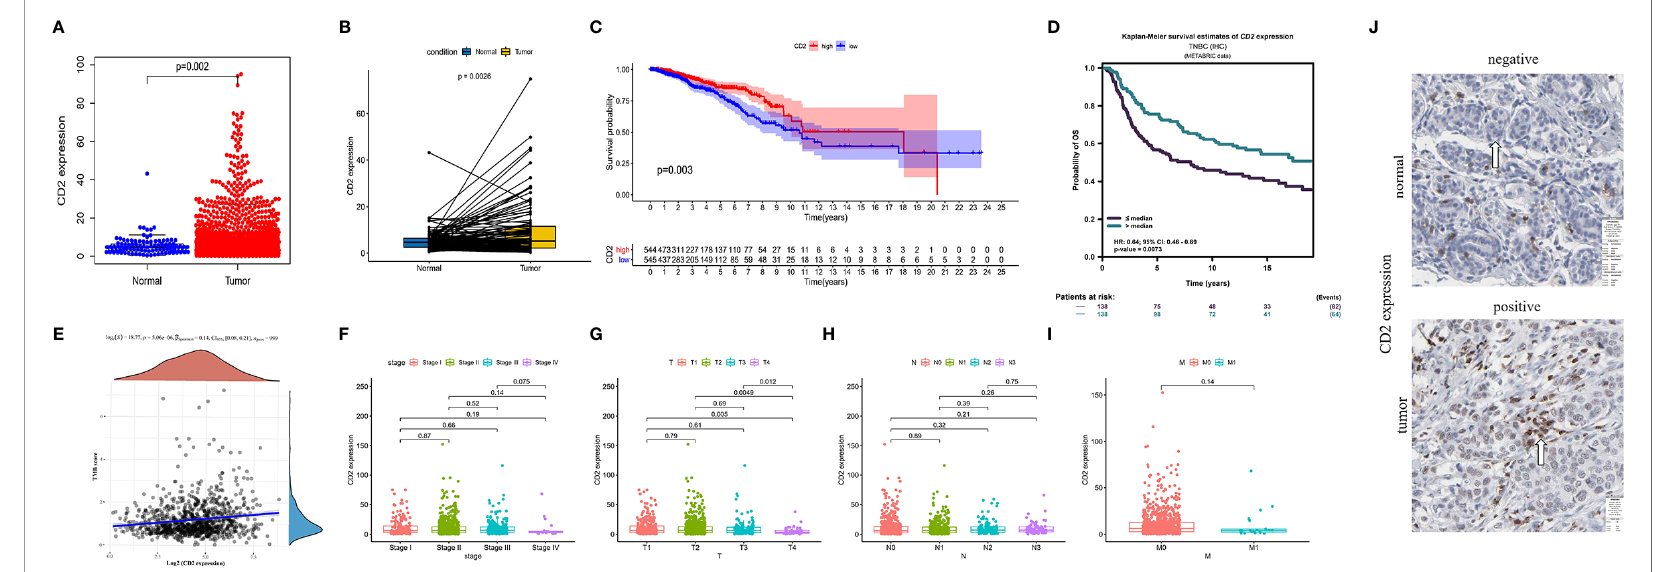
FIGURE 6 | CD2 expression, survival, and clinicopathological characteristic analyses. CD2 was differentially expressed between tumor tissues and (A) normal tissues (Wilcoxon rank sum test p = 0.002) and (B) paired normal tissues deriving from the same one tumor patient (Wilcoxon rank sum test p = 0.0026). (C) Survival analysis of BRCA patients with low and high CD2 expression (based on median expression) in the TCGA database (log-rank test p = 0.003). (D) Survival analysis of triple-negative BCa patients with low and high CD2 expression (based on median expression) in the METABRIC database (log-rank test p = 0.0073). (E) Correlation analysis of CD2 expression and TMB ( p < 0.001, r Spearman = 0.14). (F – I) Kruskal – Wallis rank sum tests of the associations of CD2 expression with TNM staging. (J) Immunohistochemistry analysis of CD2 protein expression in normal and BRCA tissues from the Human Protein Atlas (HPA) database. Normal breast tissue – patient id: 2733, antibody: HPA003883, staining: not detected, intensity: negative, quantity: none; tumor tissue – patient id: 2015, antibody: HPA003883, staining: low, intensity: weak, quantity: